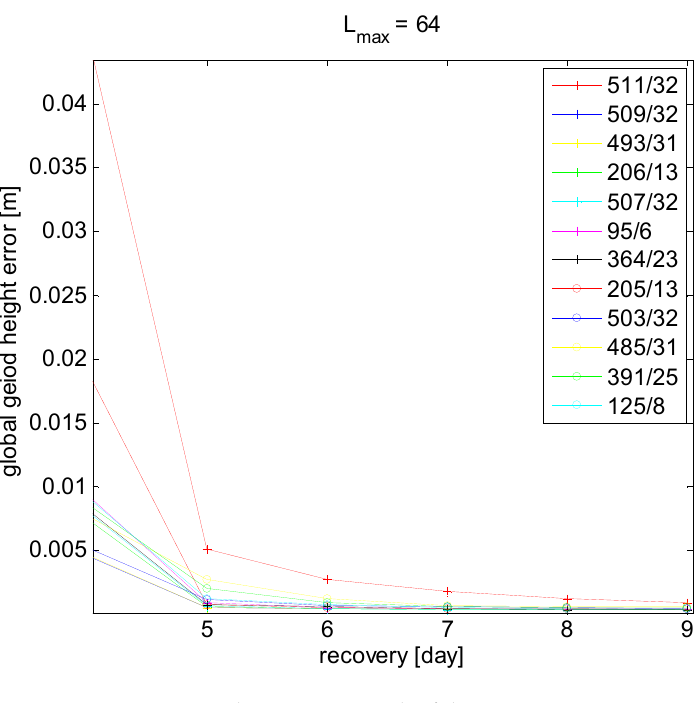
Figure 3. The zoom-in graph of the Figure 2.